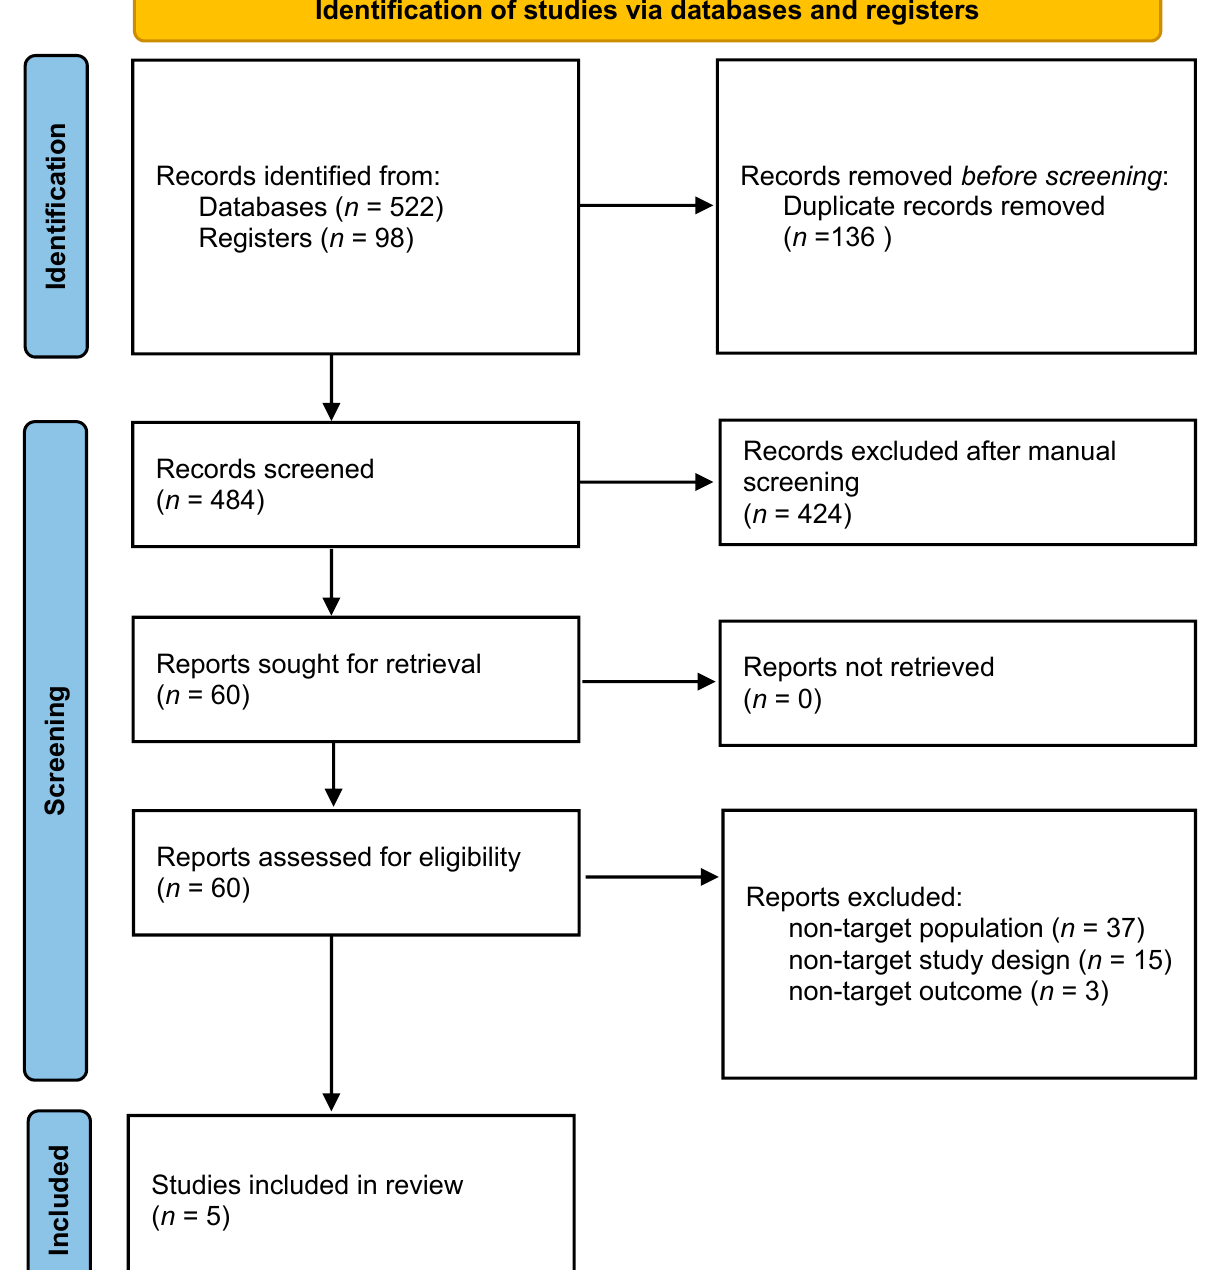
Figure 1. PRISMA Flow